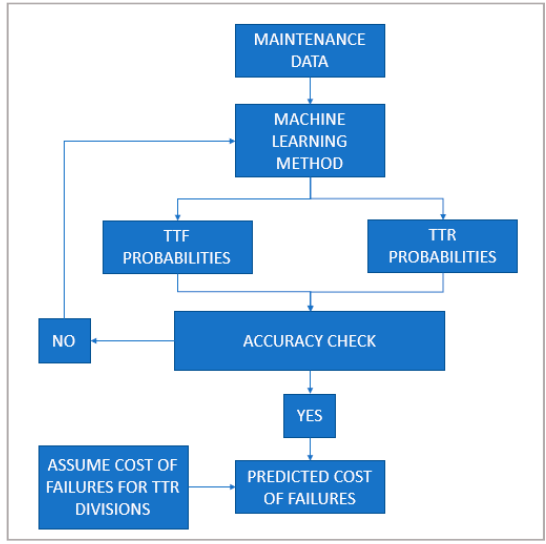
Figure 2. Schematic of developing the decision support tool to predict cost of failures for wind turbines; TTF: time-to-failure; TTR: